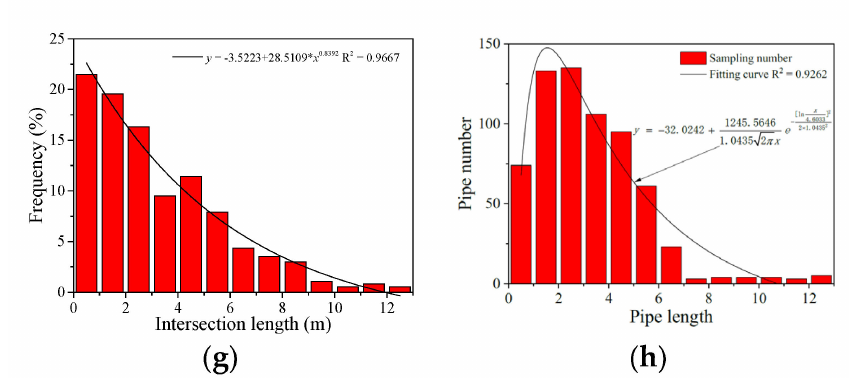
Figure 1. Fracture network model and corresponding geometric and hydraulic properties. ( a ) Three- dimension DFN model; ( b ) Intersections; ( c ) Pipe structure; ( d ) Backbone structure; ( e ) Graph structure (nodes and edges); ( f ) Water head distribution; ( g ) Frequency distribution of fracture lengths; ( h ) Frequency distribution of pipe lengths.